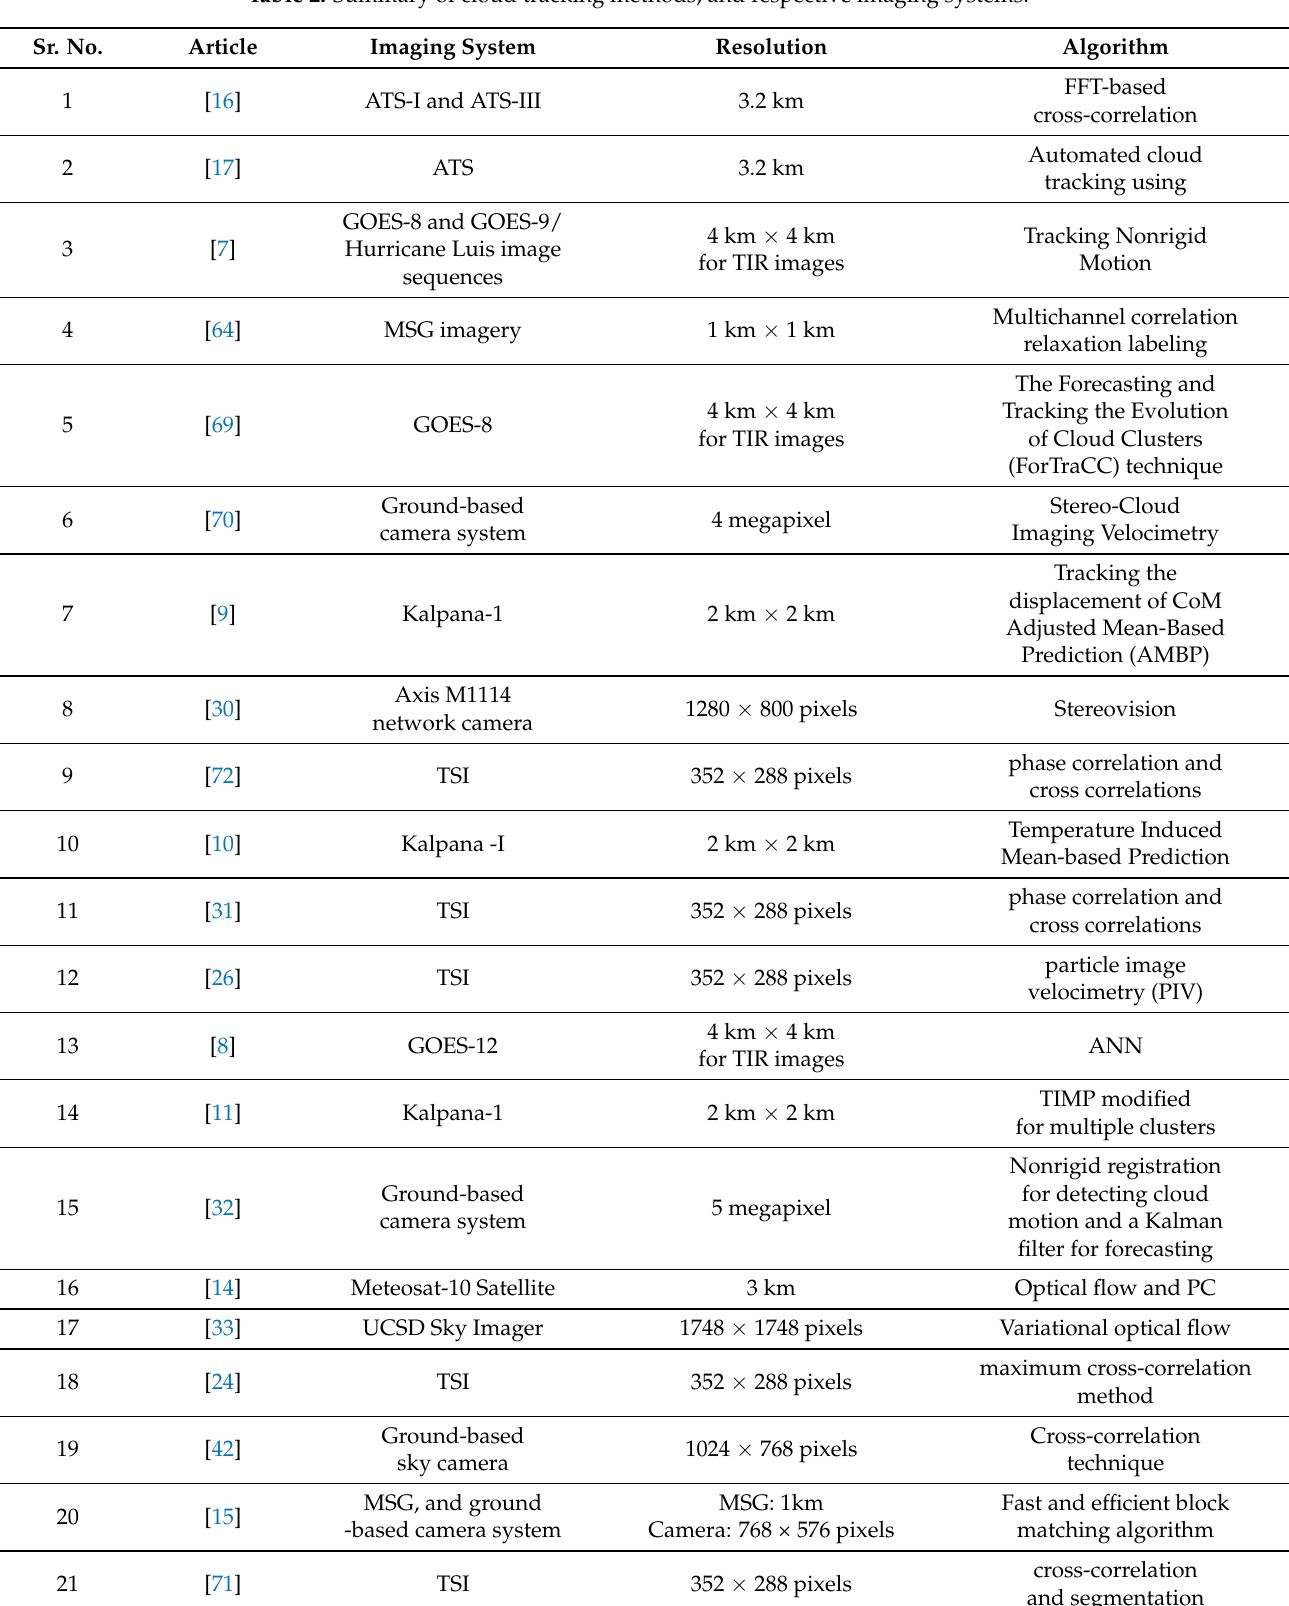
Table 2. Summary of cloud tracking methods, and respective imaging systems. Sr.